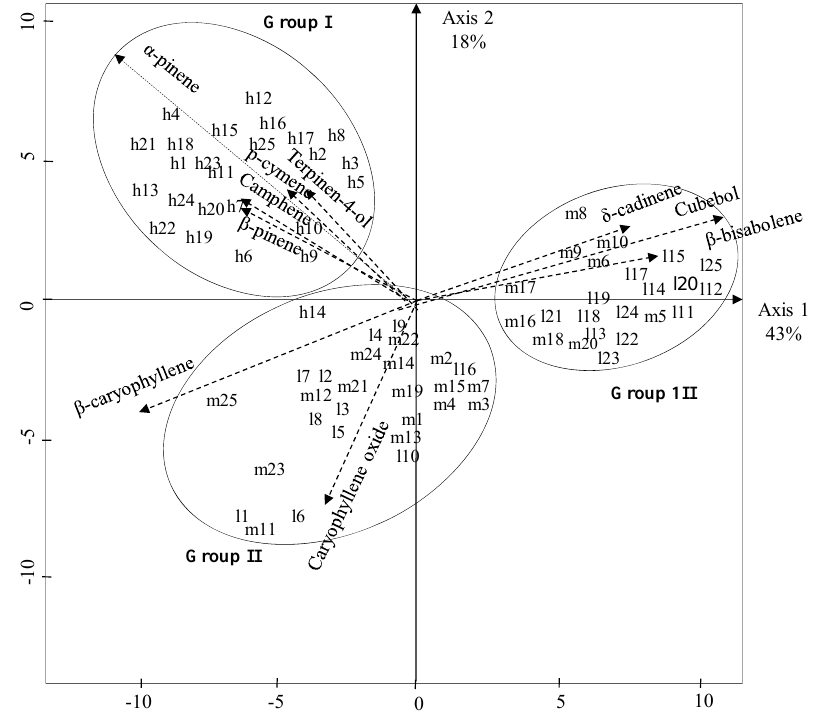
Figure 1. Tow-dimensional mapping of the P.C.A. analysis of Pistacia lentiscus L . individual distribution from low, mid and high altitude sites in Algeria (l: low; m: medium and h: high altitude